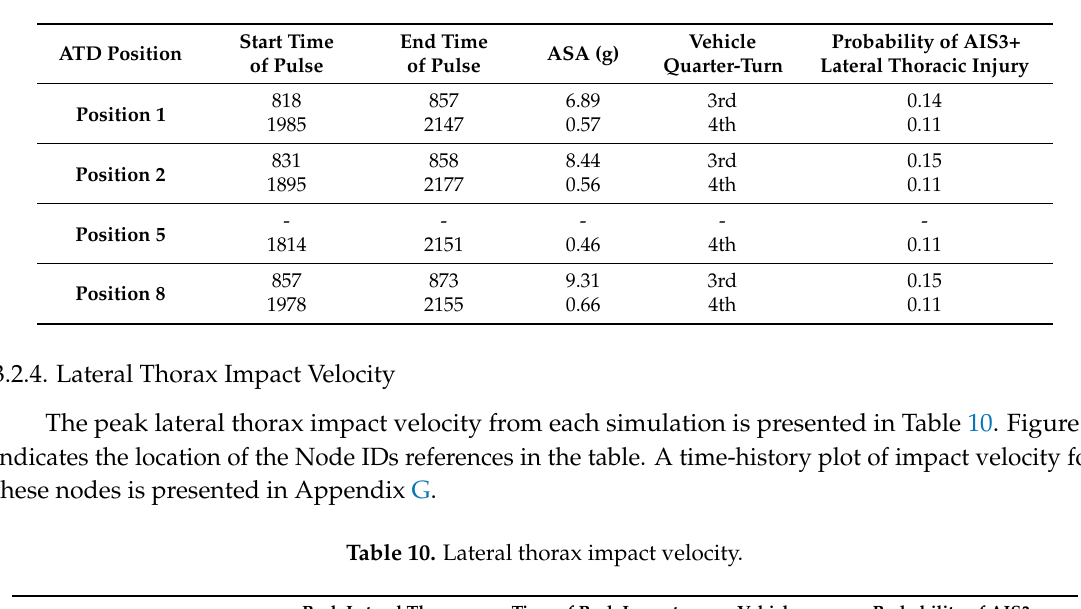
Table 9. Average Spinal Acceleration-10 (ASA-10) results.